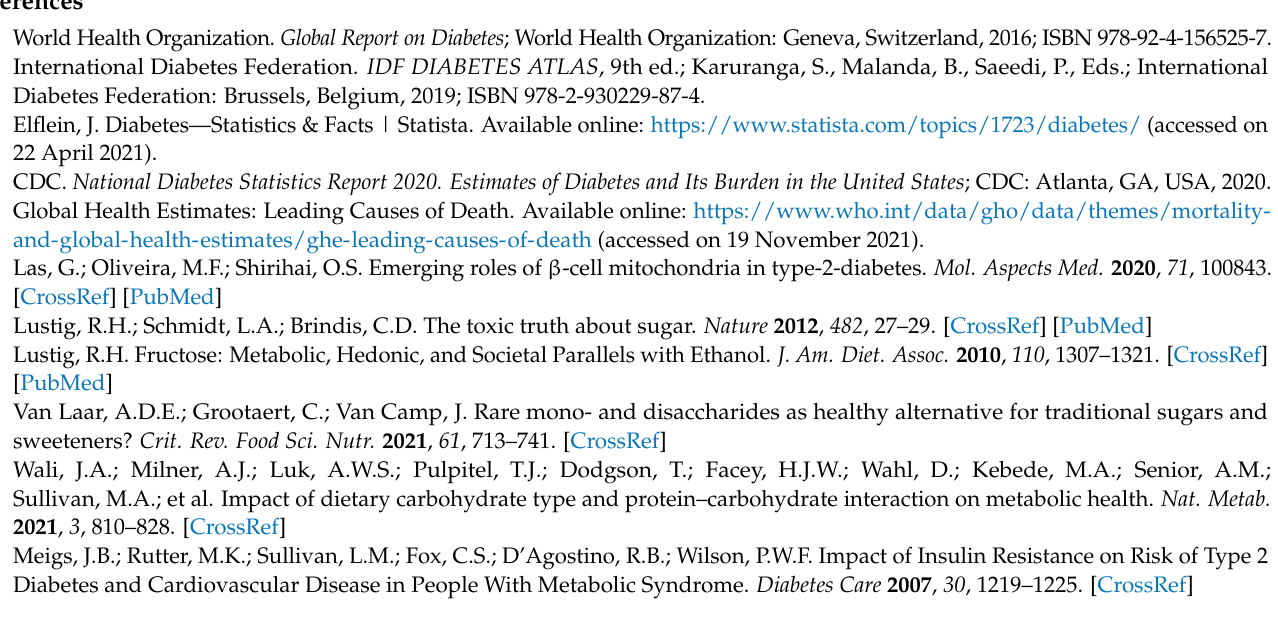
description. Table S3: Proportion of patients, expressed as a percentage, who have abnormal serum glucose (Gluc), total cholesterol (Chol), LDL, HDL, and triglycerides (TG) in male and female patients for individual age groups and in the corresponding total population. Table S4: Mean ± 95% CI of serum glucose (Gluc), total cholesterol (Chol), LDL, HDL and triglycerides (TG) in male and female patients for individual age groups and in the corresponding total population. Table S5: List of LMA drug group with the corresponding ATC code and total frequency of prescriptions. Table S6: List of DFD drug group with the corresponding ATC code and total frequency of prescriptions. Figure S1: Age-specific results of blood cholesterol levels. Figure S2: Age and sex in relation to serum cholesterol level. Figure S3: Age-specific results of LDL blood levels. Figure S4: Age- and sex-specific serum LDL and HDL levels. Figure S5: Age-specific results of blood triglyceride levels. Figure S6: Age- and sex-specific serum triglyceride levels. Figure S7: Age-specific blood glucose readings. Figure S8: Age- and sex-specific serum glucose levels. Figure S9: Age- and sex-specific drug